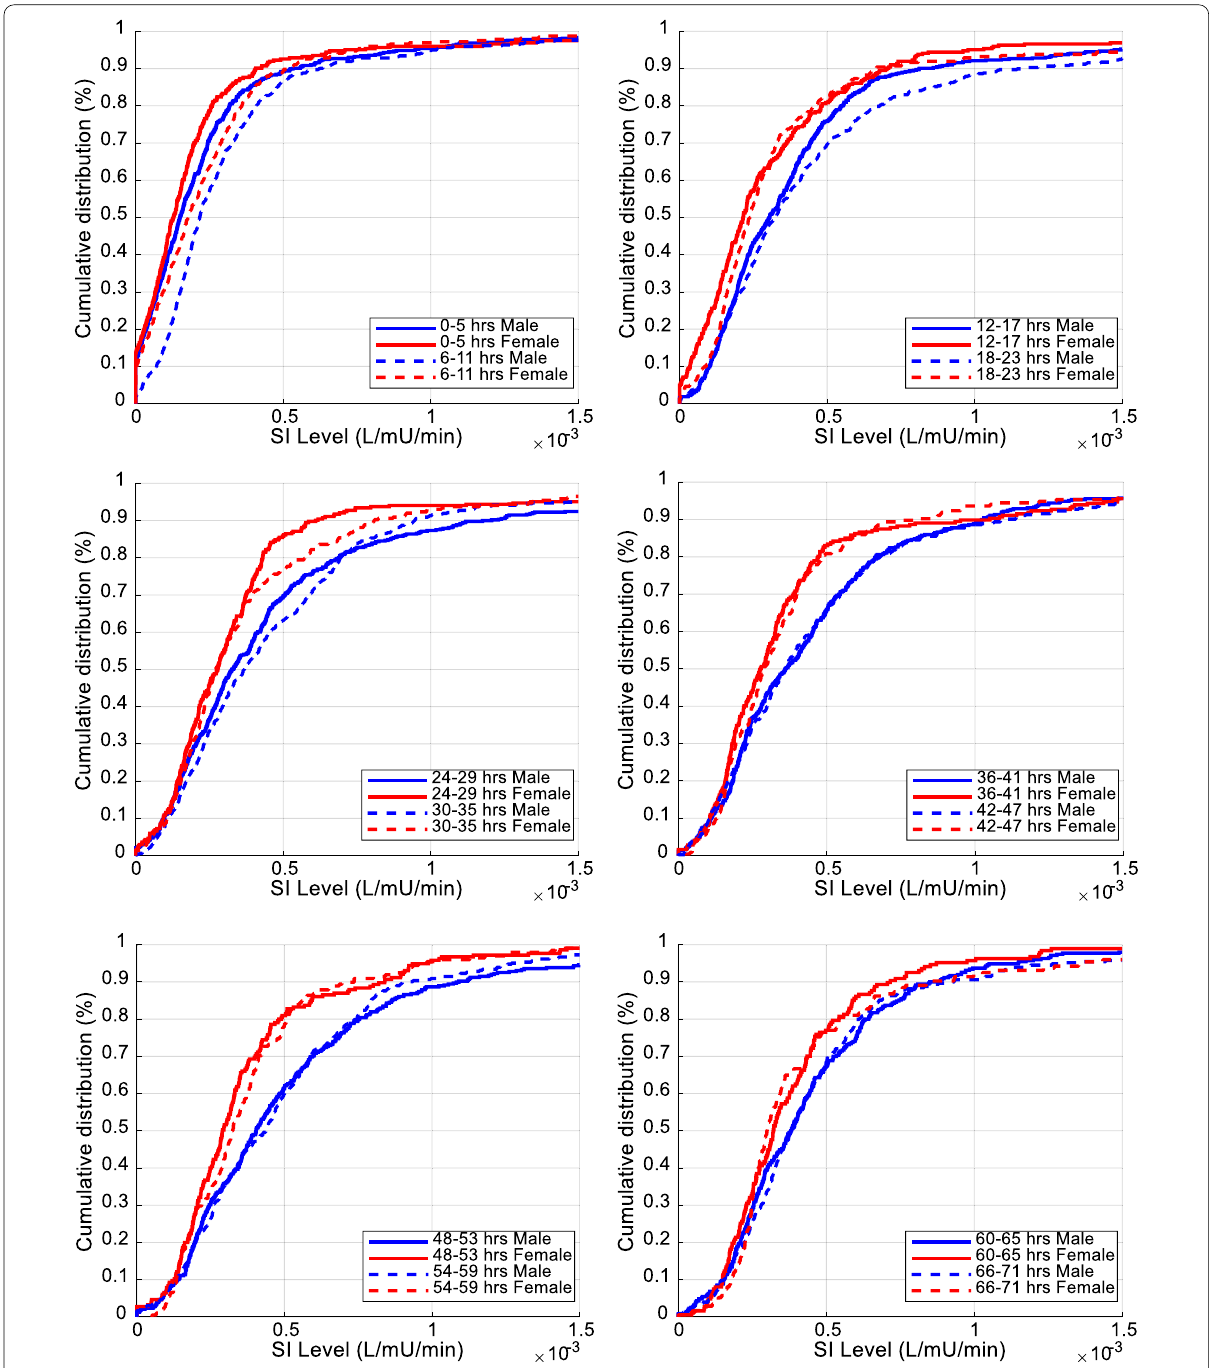
Fig. 3 Comparison of cumulative distribution of SI levels (L/mU/min) between male and female over 6-h time intervals for the first 72 h of